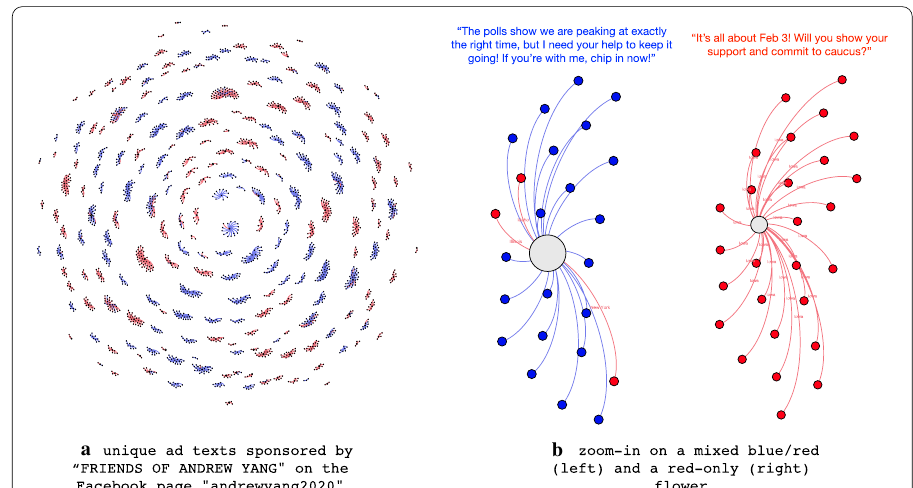
Fig. 14 a Network of “flowers” connecting each unique ad text (i.e., a flower’s center node) with all of the ads that use that exact text as their creative body. The ad text instances/associated ad IDs (petal nodes) are colored based on whether or not they are regionally-dominated: nodes representing regionally-dominated ads ( ≥ 99% of impressions come from one region) are red, and nodes representing non-regionally-dominated ads are blue. b Zoom-in on two flowers, one containing regionally-dominated ads only (right), and one containing both regionally-dominated and non-regionally-dominated ads (left). The text at the top is the ad text associated with the flower center, and thus every ad ID node connected to